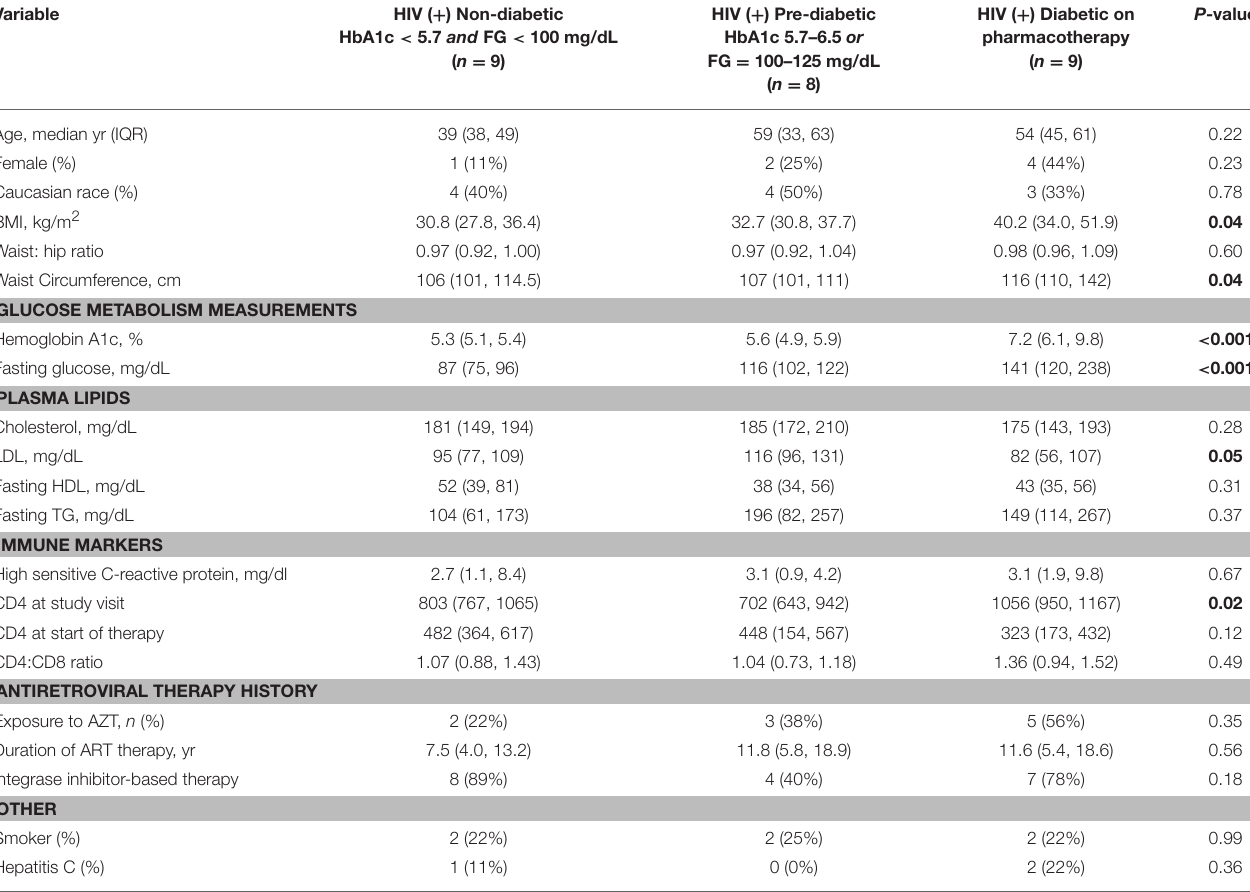
TABLE 1 | Cohort demographic and clinical characteristics according to glucose tolerance. Variable